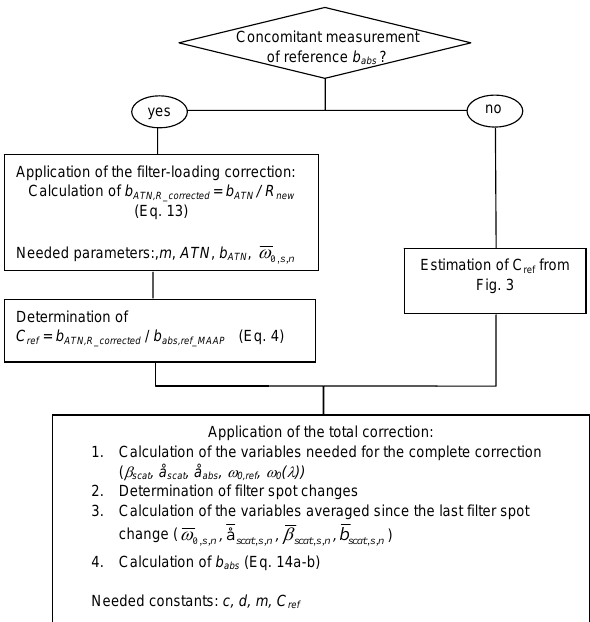
Fig. 1. Description of the sequence of steps to apply the new cor- rection